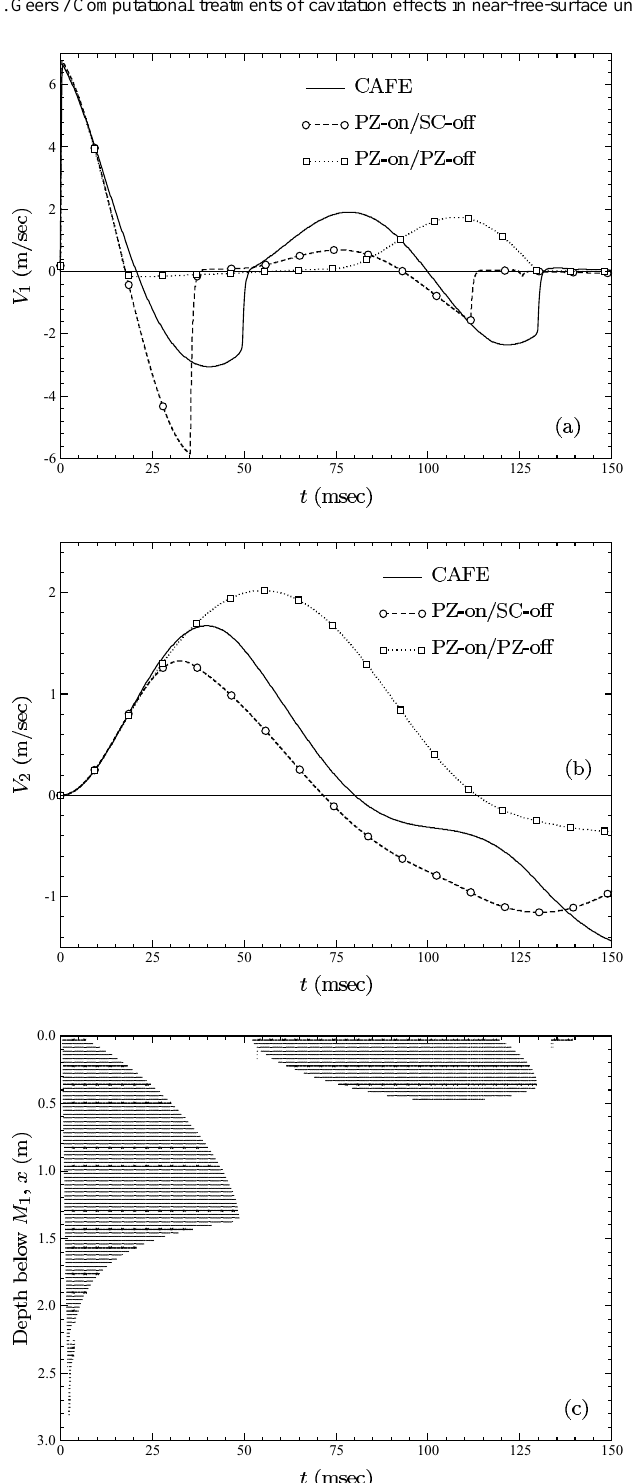
Fig. 6. (a) V 1 - and (b) V 2 -response histories for M 2 /M 1 = 5 , demonstrating the performance of two WSAs(PZ– Pressure Zero, SC – Separation Closure). (c) Cavitation